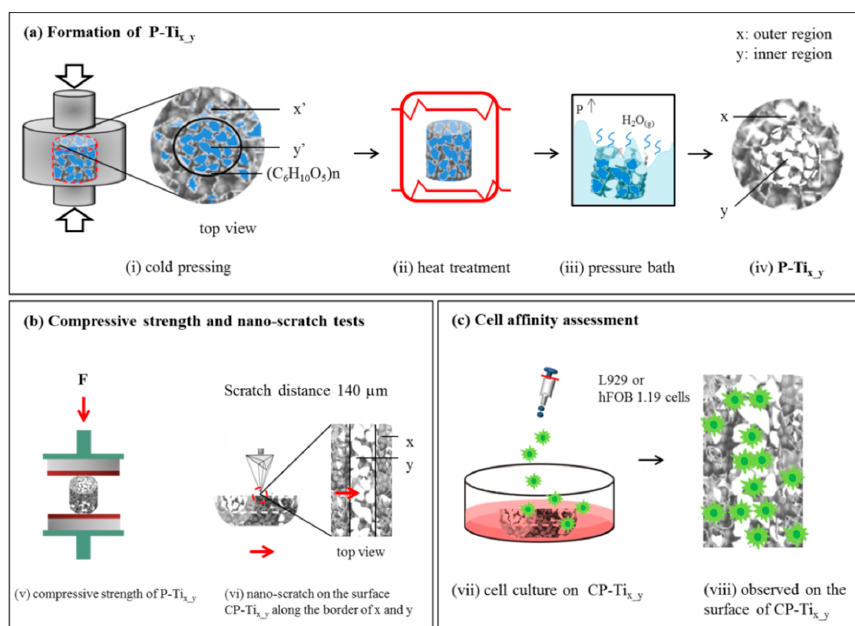
Figure 1. ( a ) An illustration of forming dual porous titanium scaffold (P-Ti x_y ): ( i ) Cold pressing